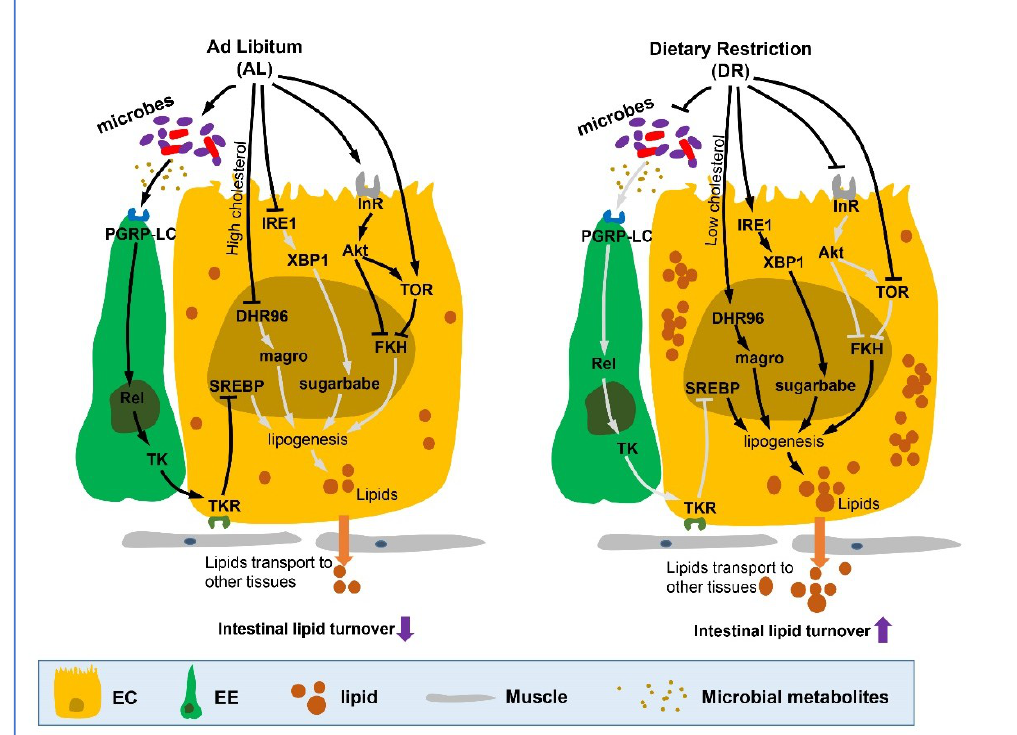
Figure 2. DR up-regulates intestinal lipid metabolism. Dietary restriction or its mimetics promote the adaptation towards triglyceride usage, increase lipid accumulation and fat storage in the fly gut, and also increase lipid transport to other tissues from the gut. This process is mediated by a range of hormones and pathways including Akt/TOR pathway, microbes regulated IMD pathway, endoplasmic reticulum (ER) stress related IRE1/XBP1 signaling module which ultimately induce the expression of lipid metabolism-related genes or transcription factors such as magro, sugarbabe, and FKH in nucleus. It should be noted that nuclear receptor DHR96 is activated in low cholesterol dietary conditions (cholesterol restriction) which then causes an increase in the transcription of the downstream bifunctional enzyme magro (with both Gastric lipase and cholesterol lipase activity), increasing the digestion of dietary TAG and cholesterol esters in lumen and lipogenesis in ECs. (Lines represent signaling pathways, arrows represent activation and blunt arrows represent inhibition. Light gray lines refer to path which is blocked or inhibited). EC, enterocyte; EE, enteroendocrine